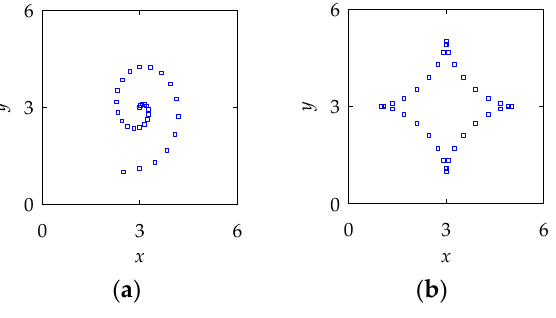
Figure 9. Point-clouds created using the parametric-equation-based approach. ( a ) Moreu; ( b ) Sik.